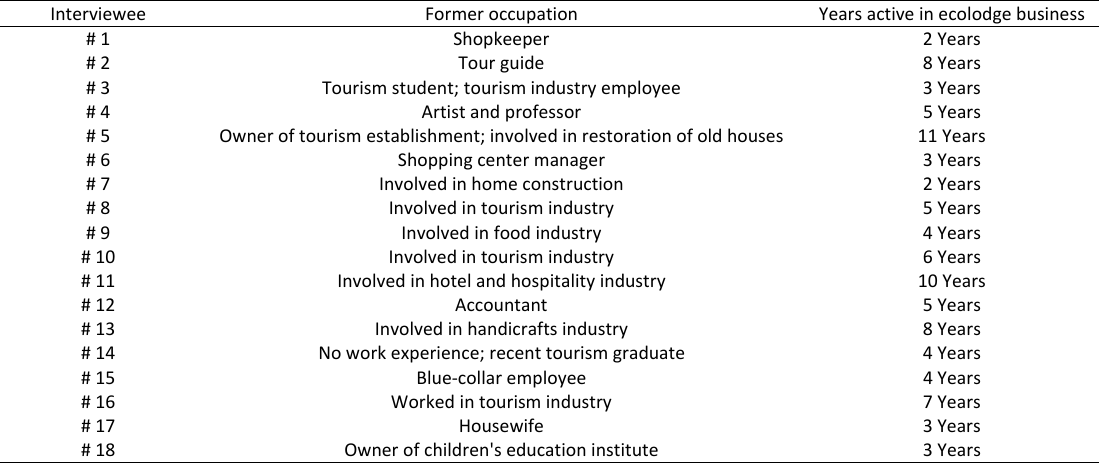
Table 2: Interviewed ecolodge owners/operators